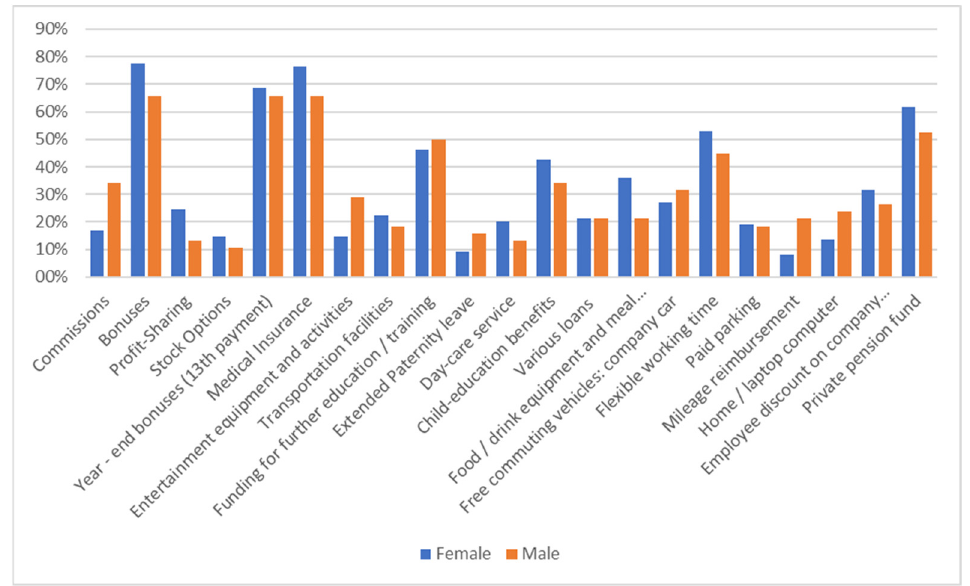
Figure 5. Percentage of employees who prefer to receive different types of benefits according to gender.